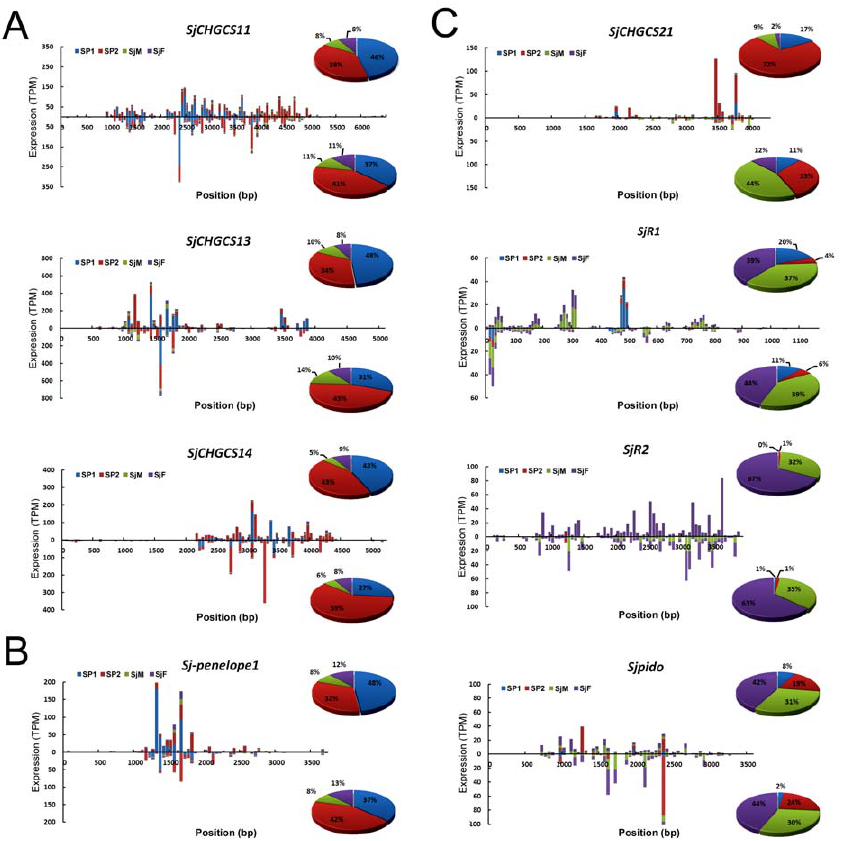
Figure 6. The distribution and abundance of retrotransposon-derived siRNAs in different small RNA libraries from adult worms. Bars with different colors were created to indicate the abundance (reflected as TPM value) of retrotransposon-derived siRNAs in different libraries. A. Endo-siRNAs mapped to the LTR retrotransposons, SjCHGCS11 , SjCHGCS13 , and SjCHGCS14 . Both sense and antisense siRNAs generated from these LTR elements were enriched in the SjAgo2-specific libraries SP1 and SP2. B. Endo-siRNAs mapped to Penelope -like retrotransposon Sj-penelope1 . Both sense and antisense siRNAs generated from the retrotransposon were dramatically accumulated in the SP1 and SP2 libraries. C. Endo-siRNAs mapped to the LINEs, SjCHGCS21 , SjR1 , SjR2 , and Sjpid o. Sense siRNAs originated from SjCH GCS21 were enriched in the SjAgo2-specific libraries. However, siRNAs generated from SjR1 and Sjpido were at a low level in the SP1 and SP2 libraries. SjR2 -derived siRNAs were hardly detected in these two libraries. The percentage of total siRNAs derived from a particular TE among the four libraries was calculated by using the sum of TPM value of each siRNA and was displayed in the pie charts. The upper panel in each chart represents sense siRNAs; the lower panel in each chart represents antisense